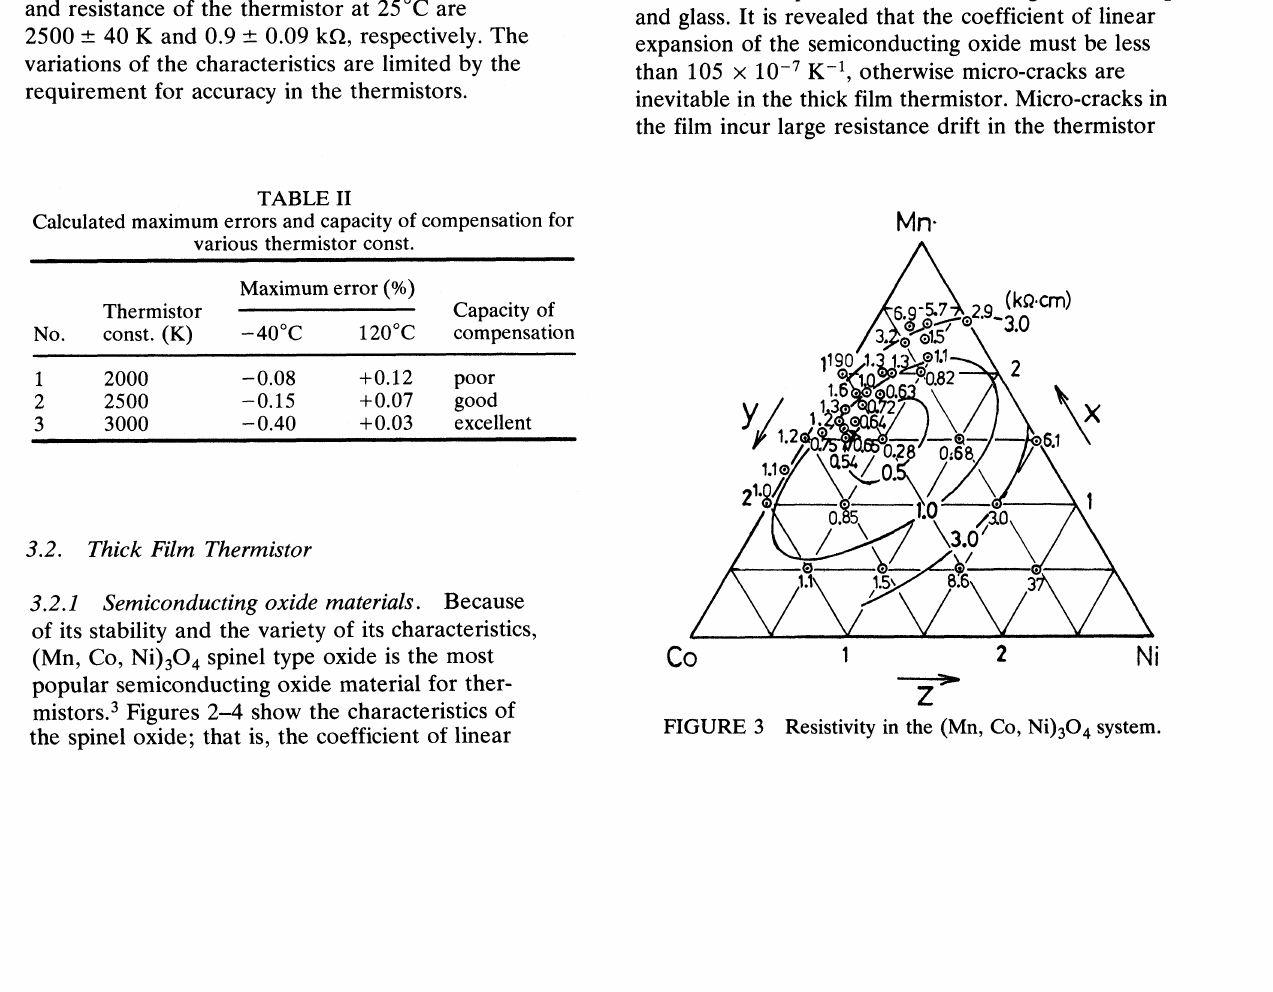
FIGURE 2 Coefficient of linear expansion in the system of (Mn, Co, Ni)304.